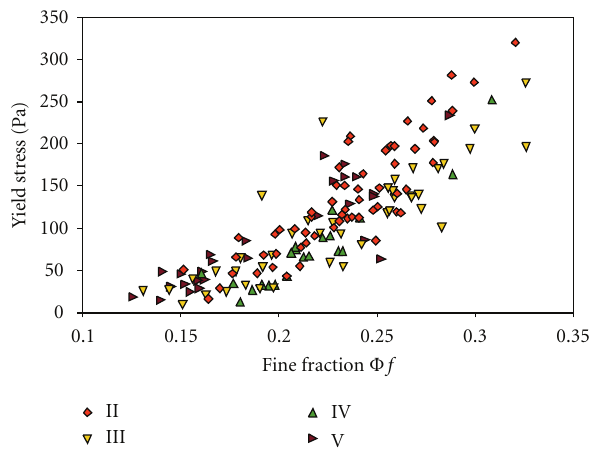
Figure 4: Relation between fine fraction and yield stress of MOb